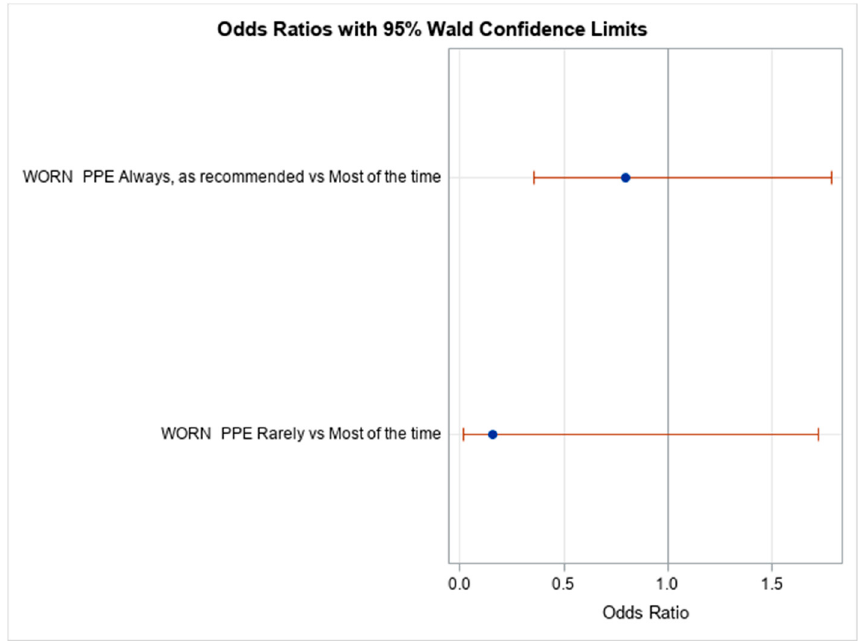
Figure 2. Association between occupational exposure and seroprevalence. Odds ratios of seropositivity in participants with PPE use as recommended and PPE use rarely were compared to those with PPE use most of the time. Odd ratios estimates were calculated using logistic regression.